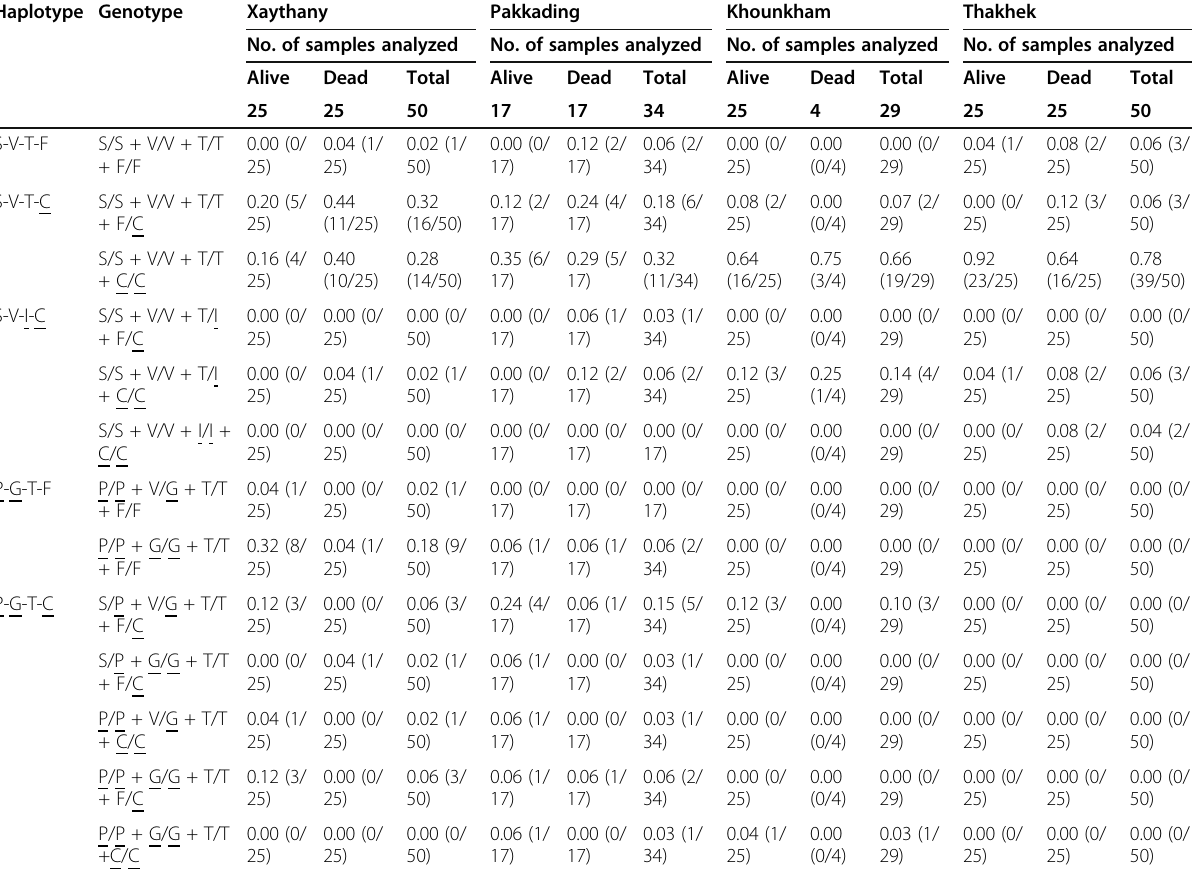
Table 2 Frequency of thirteen kdr genotypes in Ae. aegypti larvae collected from four populations Haplotype